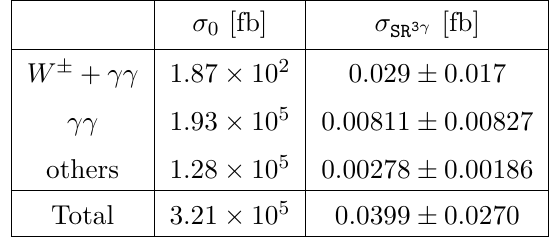
Table 3 . Cross sections (in fb) after parton-level cuts (table 1) only, σ 0 , and after the SR 3 γ selection criteria (eq. (5.2)), σ . SR 3 γ